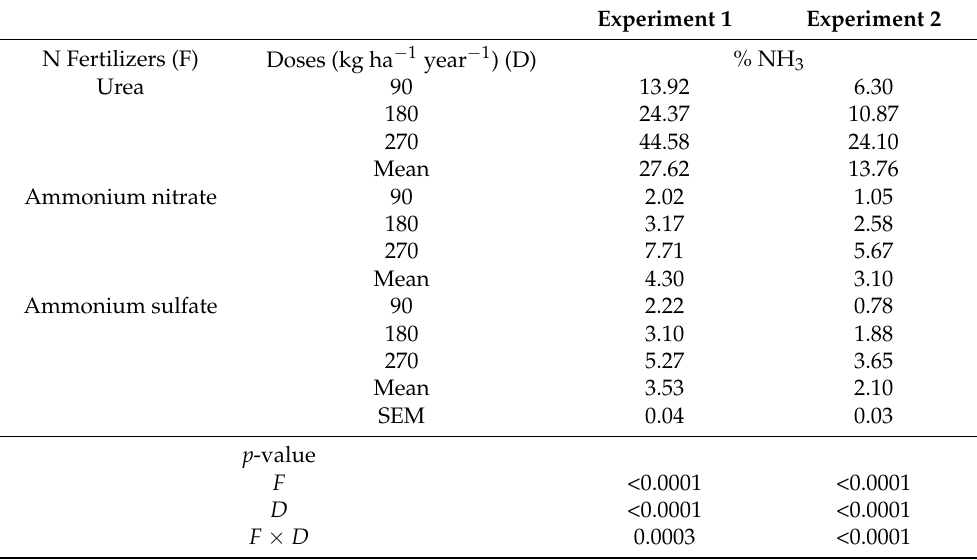
Table 1. Emission factors (% N applied lost as NH 3 ) in marandu palisade grass pastures in fertilization with different N sources and doses in two experiments. Experiment 1 Experiment